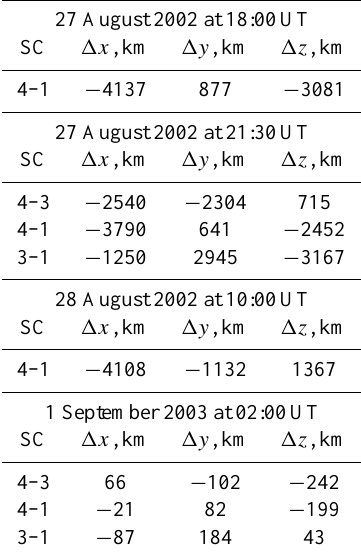
Table 1. Cluster satellite separations in